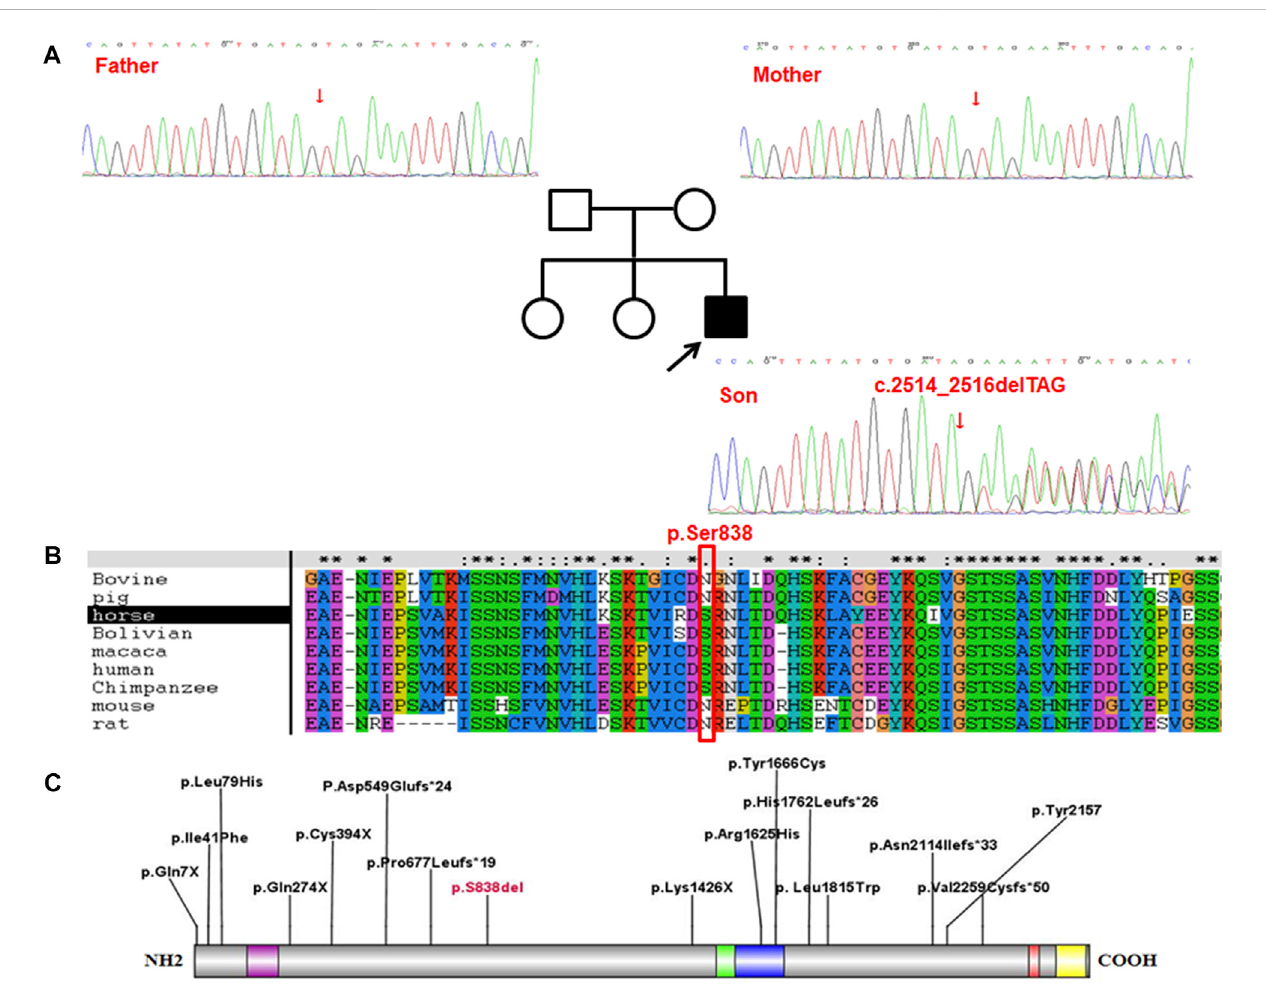
FIGURE 1 The proband carried the c.2514_2516delTAG (p.Ser838del) mutation in SETD2 gene. (A) , The results of Sanger sequencing on (C) 2514_2516delTAG (p.Ser838del) mutation in SETD2 gene in the proband and his family. (B) , Conservative analysis at site p. Ser838 in multiple species. (C) , Distribution of the variant sites in 16 LLS